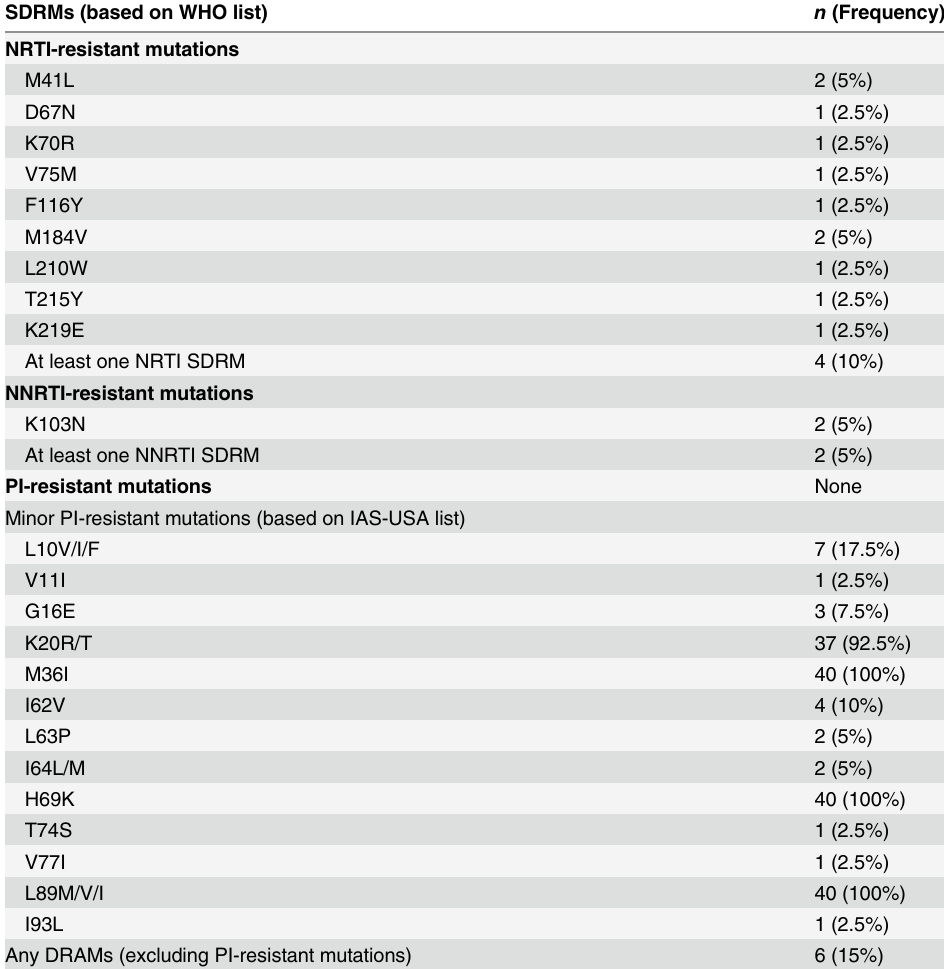
Table 2. Frequency of HIV-1 drug resistance-associated mutations among 40 sequenced samples. SDRMs (based on WHO list) n (Frequency) NRTI-resistant